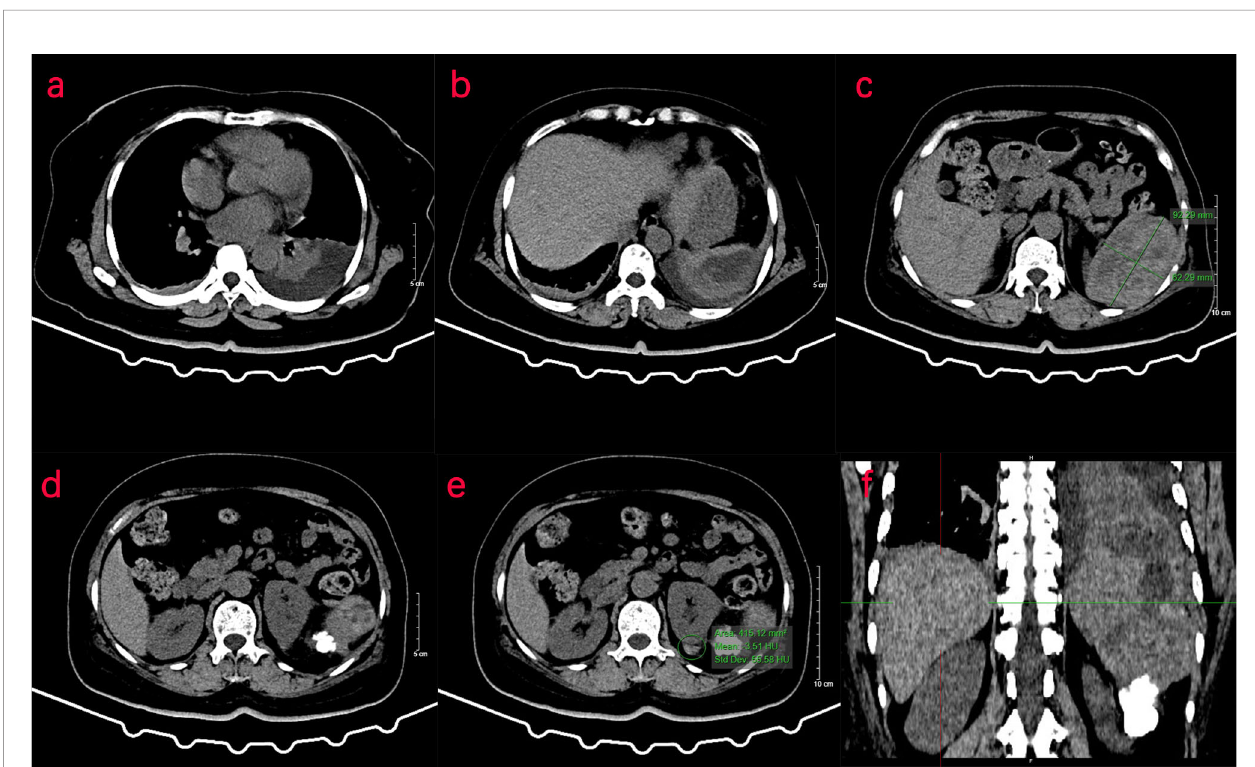
FIGURE 3 | CT examination of the patient. (A – F) CT of the upper abdomen shows abnormal density of the spleen, and the transverse position of the CT image shows pleural effusion in the left thoracic cavity. (C) In the spleen, there is a mass of mixed density shadow with unclear margin, with a maximum cross-sectional area of approximately 9.2 cm × 6.1 cm. (D, E) The left renal margin is rough, and the density of the spindle-shaped shadow is slightly higher under the left renal capsule. (F) The coronal position of the CT image shows a fl ake-like high-density shadow in the lower margin of the